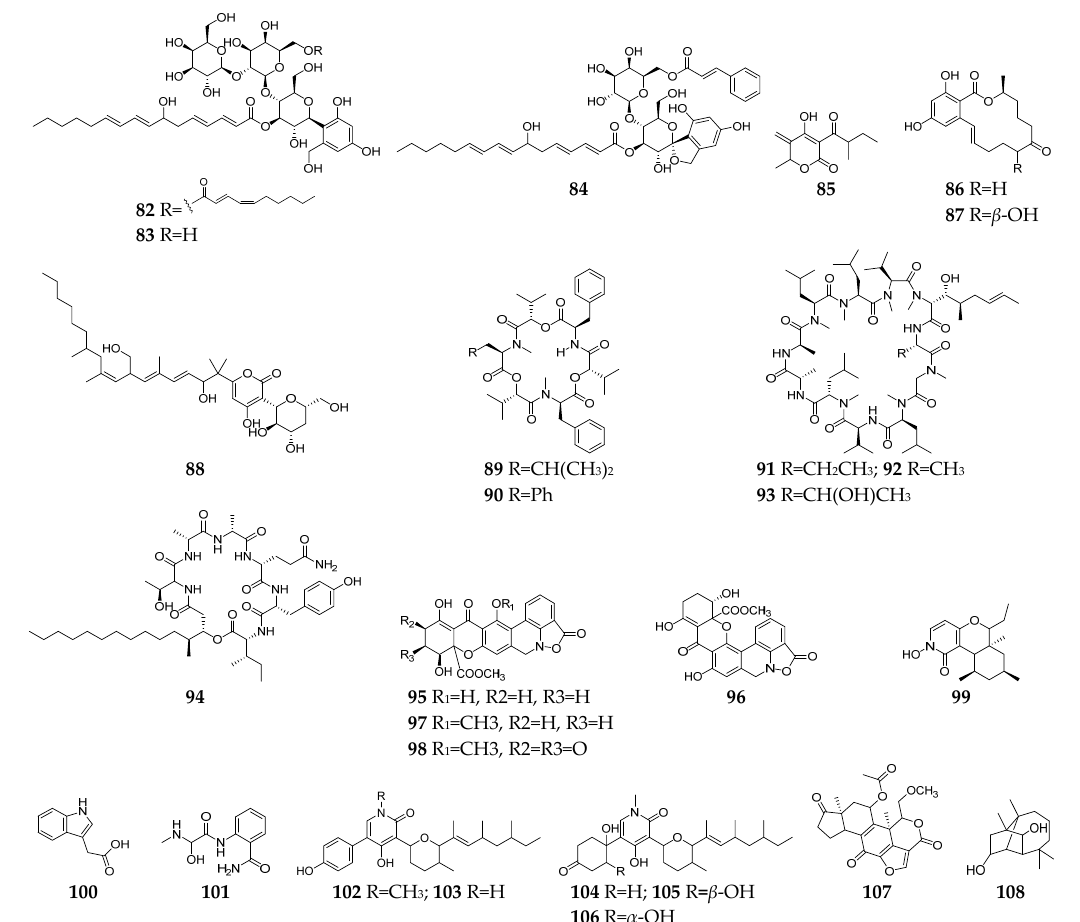
Figure 4. Fusarium -derived antifungal SMs ( 82 – 108 ). Fusaribenzamide A ( 101 ) possessed a significant anti- C. albicans activity with MIC of 11.9 µg/disc compared to nystatin (MIC = 4.9 µg/disc) [56]. Three pyridone derivatives ( 102 – 104 ) displayed significant activities against multidrug-sensitive S. cerevisiae 12gene Δ 0HSR-iERG6, and the MoA study indicated that these substances have a potent inhibitory e ff ect on NADH-cytochrome C oxidoreductase [57]. Compounds 105 – 107 were derived from strain F. oxysporum N17B, and the former ( 105 and 106 ) showed selective fungistatic activity against Aspergillus fumigatus , and the la tt er ( 107 ) had selective potent activity against C. albicans through inhibition of phosphatidylinositol 3-kinase [58]. Cul- morin ( 108 ) displayed remarkable antifungal activity against both marine ( S. marina , M.